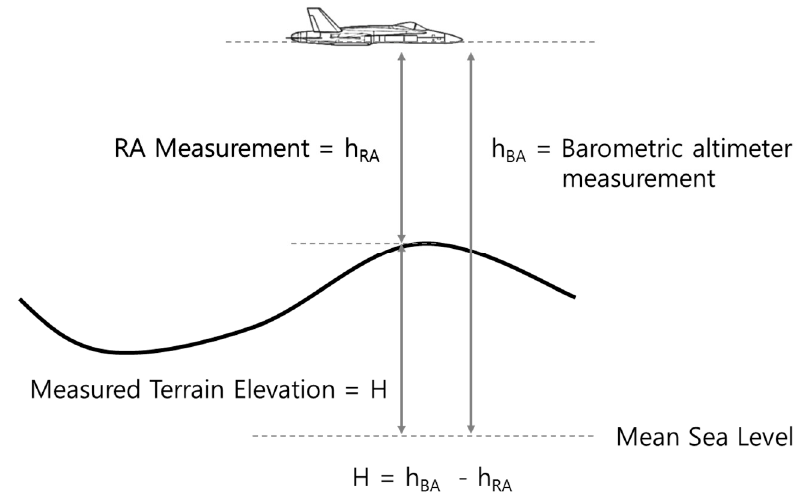
Figure 1. Measurement of TRN using RA.